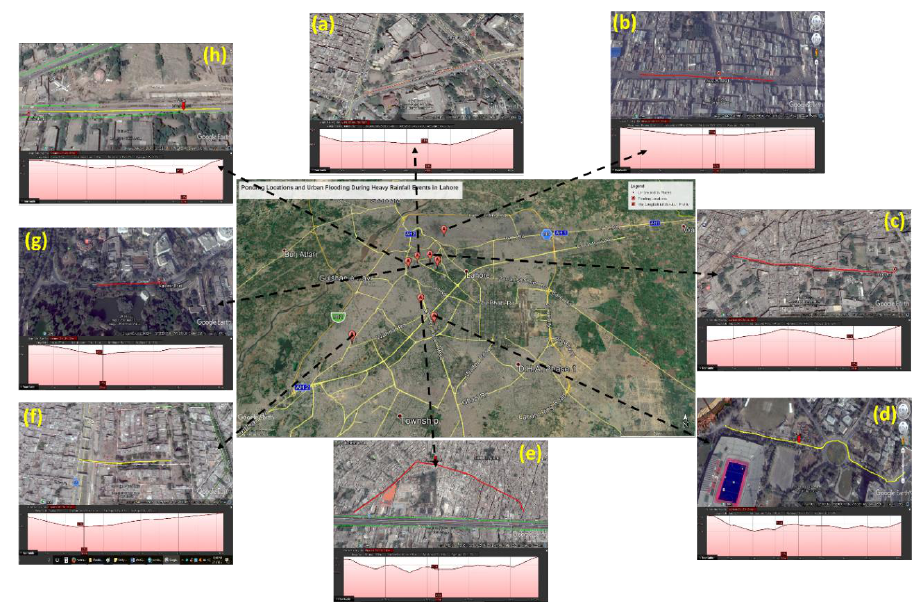
Figure 4. Longitudinal profiles of roads having flood inundation during monsoon. ( a ) GPO Bus stop ponding area (length = 270 m, slope = 13.4%); ( b ) Chowk Nakhuda ponding area (length = 235 m, slope = 2.8%); ( c ) Cooper Road ponding area (length = 541 m, slope = 6.3%); ( d ) Gaddafi Stadium ponding area (length = 637 m, slope = 6.3%); ( e ) Sultan Ahmed Road ponding area (length = 1.17 km, slope = 3.6%); ( f ) Fruit and Vegetable Market Multan Road (length = 259 m, slope = 32.7%); ( g ) Kashmir Road ponding area (length = 195 m, slope = 8.4%); ( h ) Lake Road ponding area (length = 335 m, slope = 12.2%).